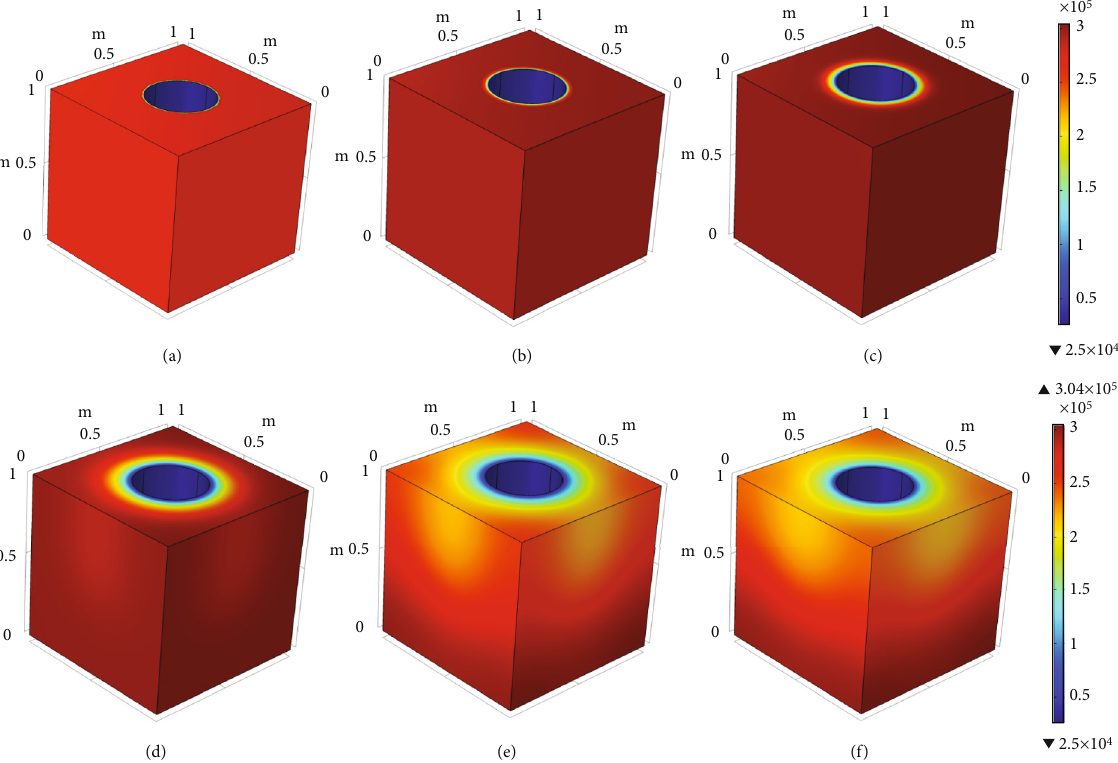
Figure 15: Pore pressure fi eld in the m = 7 coal rock: (a) t = 0 : 1 s , (b) t = 1 × 10 3 s, (c) t = 1 × 10 4 s, (d) t = 1 × 10 5 s, (e) t = 1 × 10 6 s, and (f) t = 1 × 10 7 s.